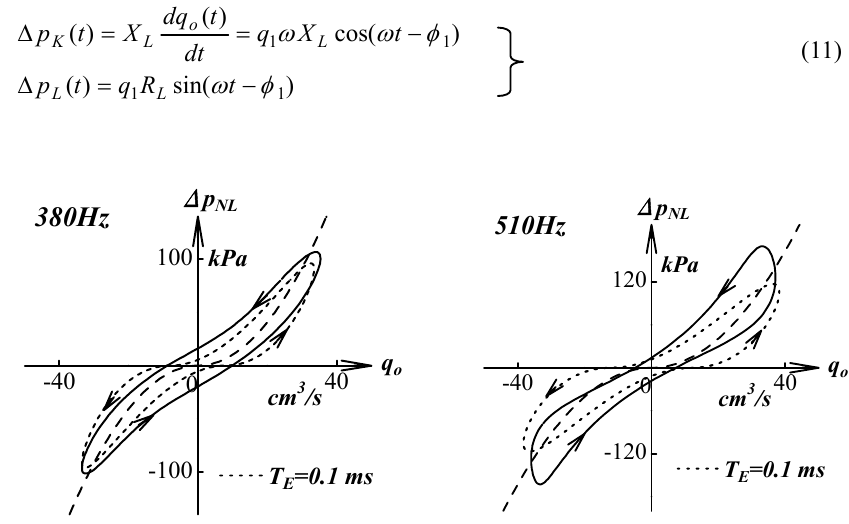
Fig.10 Unsteady characteristics of non-linear pressure loss in a reciprocating flow through